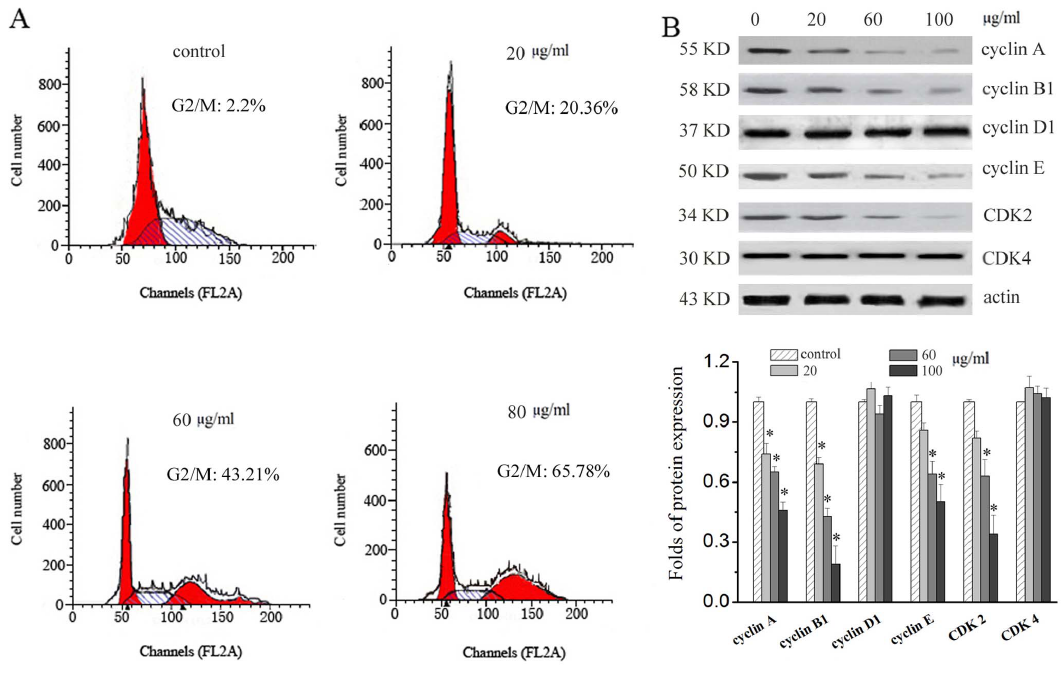
Figure 4. Effects of TCS on SW1990 cell cycle progress and cell cycle regulatory proteins. SW1990 cells were treated with indicated doses of TCS for 24 h. Cell numbers at G2/M phase increased significantly (A), the expressions of cyclin A, B1, E and CDK2 significantly decreased (B). Data represent means 6 SD of three independent experiments (* p , 0.05 compared with control).